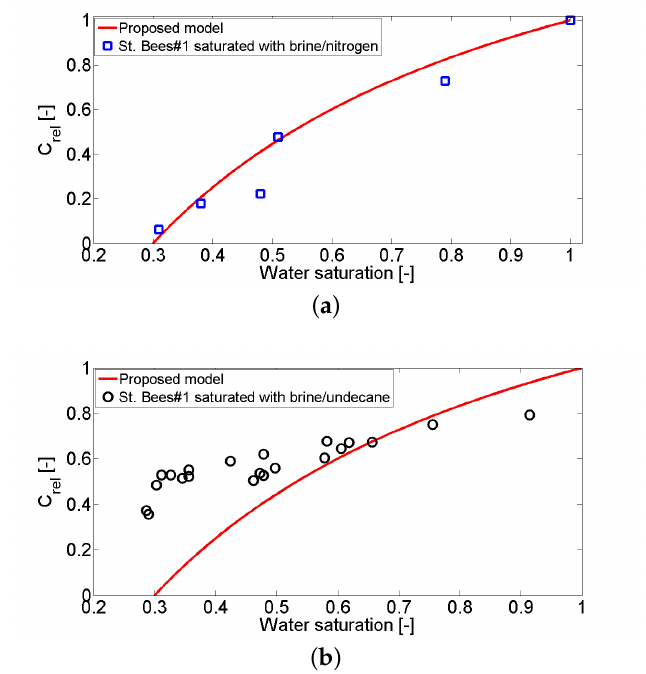
Figure 4. The variation of the relative SPCC with water saturation for St. Bees#1 (see symbols) taken from [58]: ( a ) saturated with brine/nitrogen; ( b ) saturated with brine/decane. The solid lines are predicted from Equation (29) with S wirr = 0.3, d = 130 µ m, φ = 0.19, σ w = 0.1 S/m, Σ s = 10 × 10 − 9 S and α =